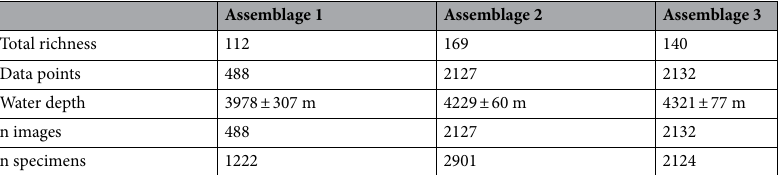
Table 1. Comparison of the different megafauna assemblages computed with k-means clustering (Fig. 1c) based on the predicted probability of occurrences of megafauna morphotypes across the whole study area; total richness refers to the original dataset including all morphotypes with no regard if they could be used in the modelling approach or if the numbers of occurrences were too low.